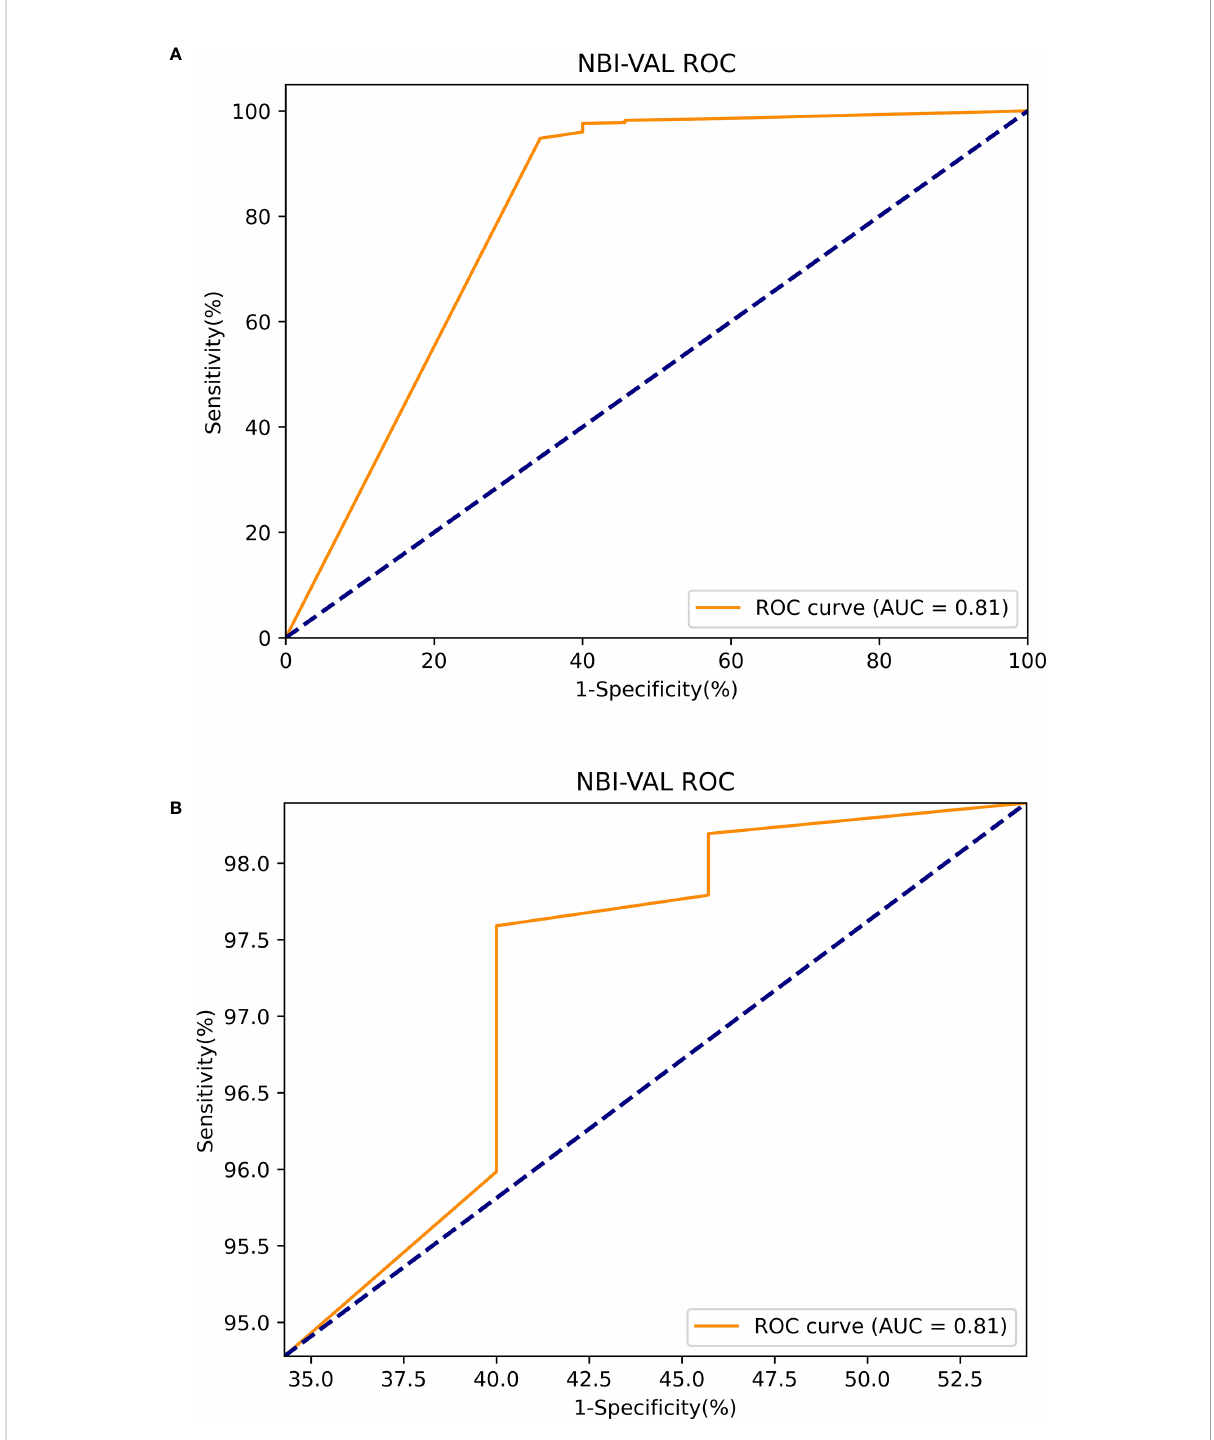
FIGURE 7 The ROC curve of the narrow band images test. (A) The global ROC curve of the narrow band images test. (B) The regional ROC curve of the narrow band images